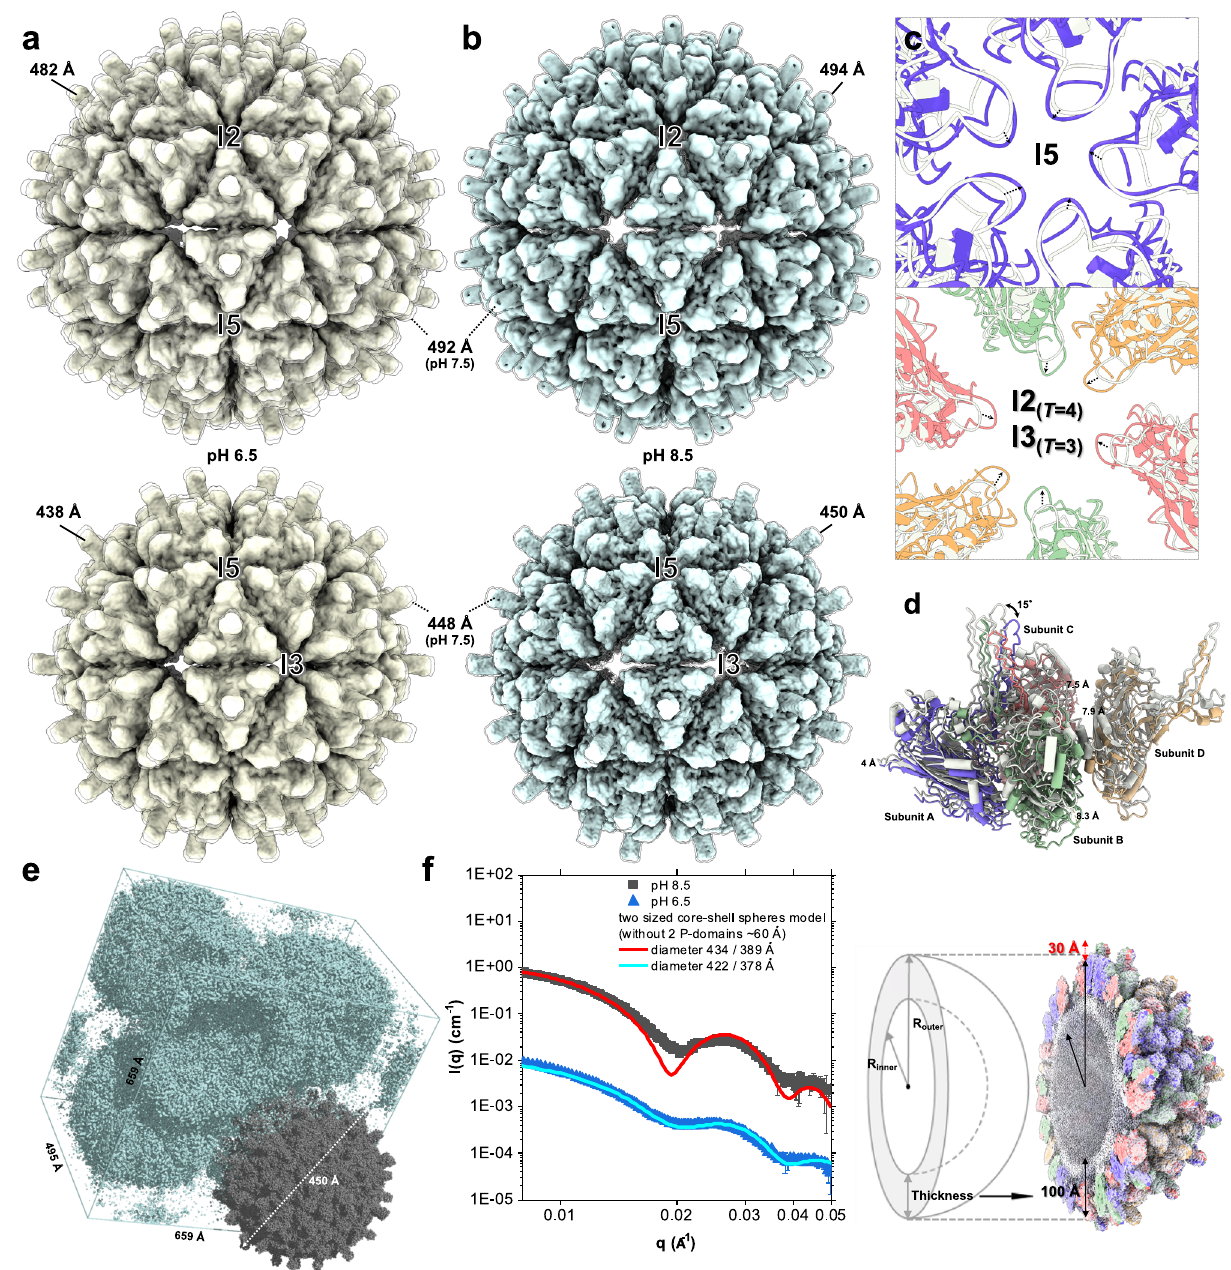
Fig. 5 | Comparisons of cryo-EM, crystal and SAXS structures of the T =4 and T =3 LSV2 VLPs at neutral, acidic, and basic pH environments. a The cryo-EM mapsof T =4(upper)and T =3(lower)LSV2VLPswithdiametersof 482and438A ̊ , respectively, at acidic pH condition are shown in dark khaki, whereas those with diameters of 492 and 448 A ̊ , respectively, at neutral pH condition, are shown in transparent rendering. b The cryo-EM maps of T =4 (upper) and T =3(lower) LSV2 VLPs with diameters of 492 and 448A ̊ at neutral pH conditions are shown in light blue, whereas those with diameters of 494 and 450 A ̊ at basic pH conditions are coloredintransparentrendering. c Superpositionofthecryo-EMstructuresof T =4 and T =3 LSV2 VLPs in neutral and acidic environments with top views of the interfaces along I5 (upper) and I2 (lower) axes, respectively. The structures of subunitsA – Dinanacidicenvironmentareshowninpurple,red,green,andyellow,